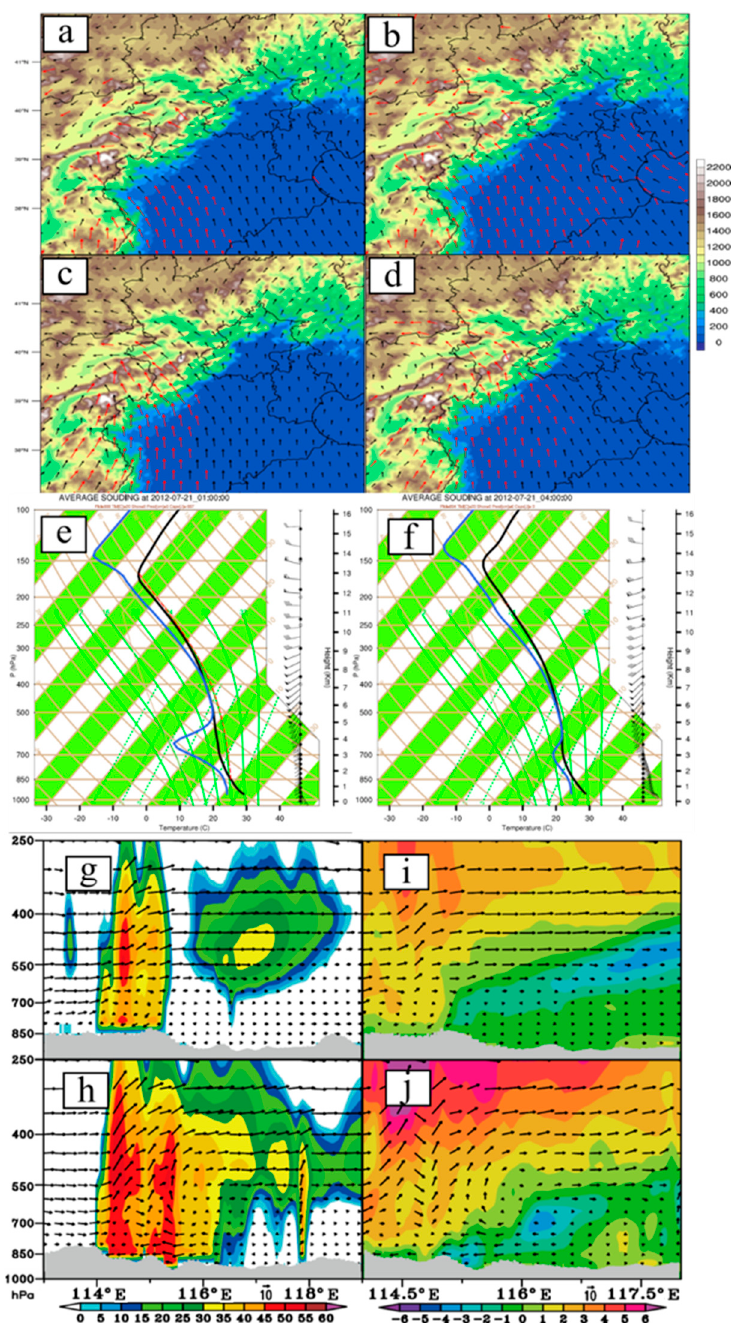
Figure 14. ( a , b ) Simulated 10 m horizontal wind (arrow), with red arrows wind speed > 5 m s − 1 . ( c , d ) Simulated horizontal wind at 850 hPa (arrow), with red arrows wind speed > 12 m s − 1 . The shading area is terrain height. ( a , c ) is at 0200 UTC, ( b , d ) is at 0400 UTC. ( e , f ) Skew-T plots of soundings averaged over the black box in Figure 3a1 at 0100 and 0400 UTC, respectively. Simulated vertical cross sections of ( g , h ) radar reflectivity (dBZ, shaded), wind field (vectors), and ( i , j ) potential temperature perturbation ( ◦ C, shaded) at ( g , i ) 0800 and ( h , j ) 0830 UTC, respectively. The gray-shading at the bottom denotes the topography profile.